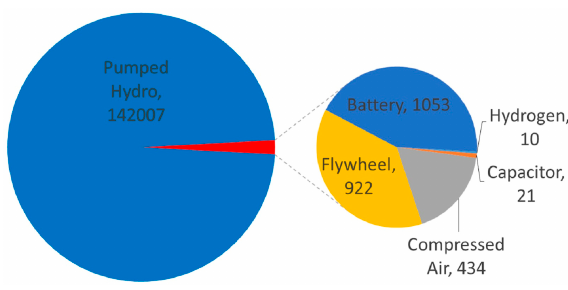
Figure 2. Global installed grid connected energy storage capacity in MW that can be used to supply electricity (created from data obtained from [7]).